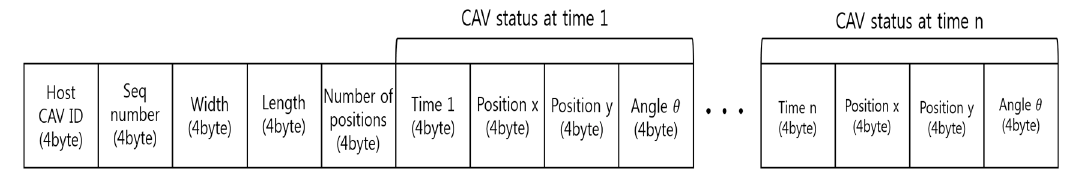
Figure 4. Definition of the lane change request message. Algorithm 1. Lane change protocol in the host CAV